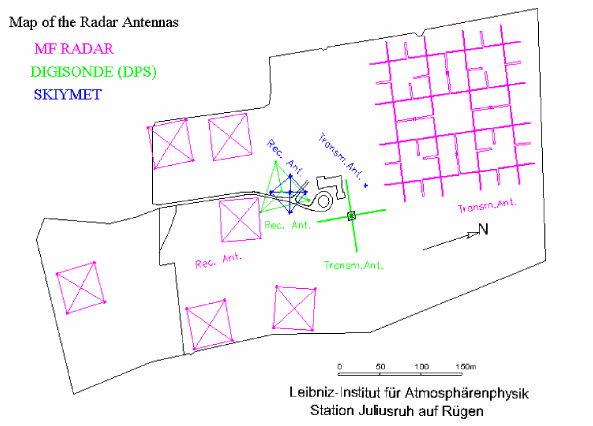
Figure 43. Position of the antennas in Juliusruh Station. The Franklin array (top right) 2004 was substituted by a Mills cross ar- ray.